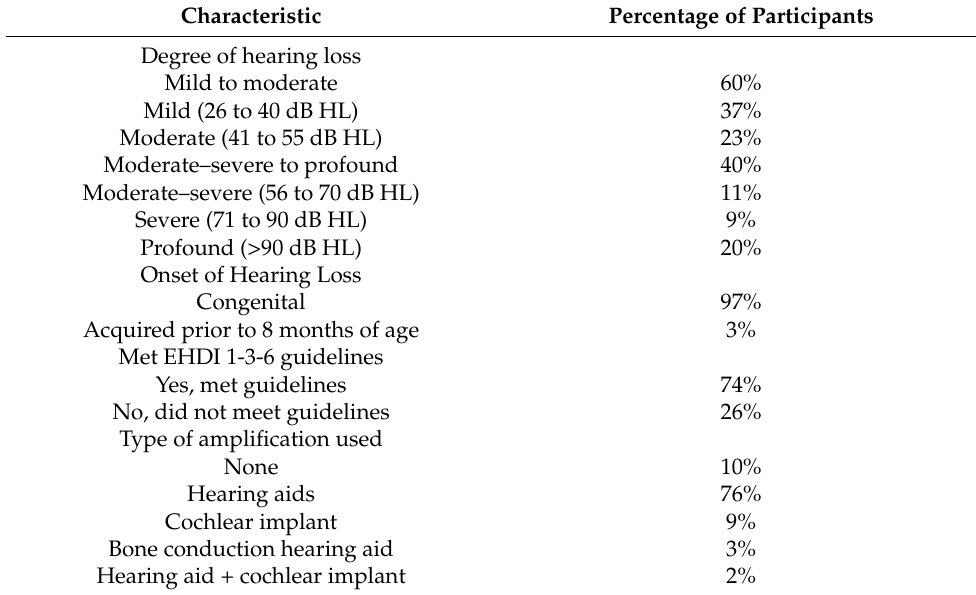
Table 2. Characteristics of the Participants’ Hearing